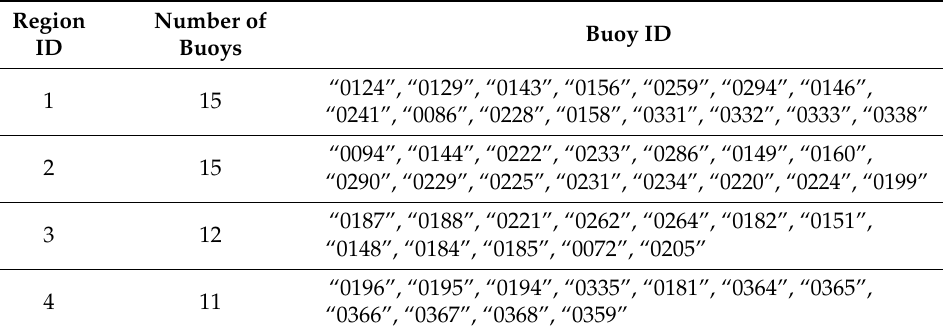
Table 8. Optimal results of layout for